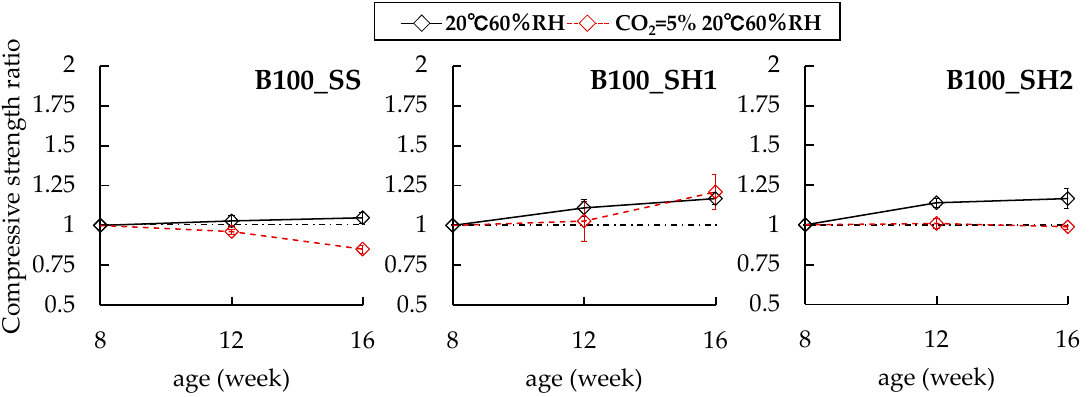
Figure 2. Compressive strength of each specimen at 8 weeks.